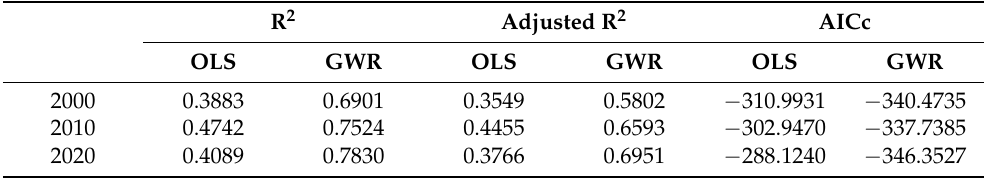
Table 3. Statistical results of GWR and OLS in 2000, 2010, and 2020 in the Qinling-Daba Mountains. R 2 Adjusted R 2 AICc OLS